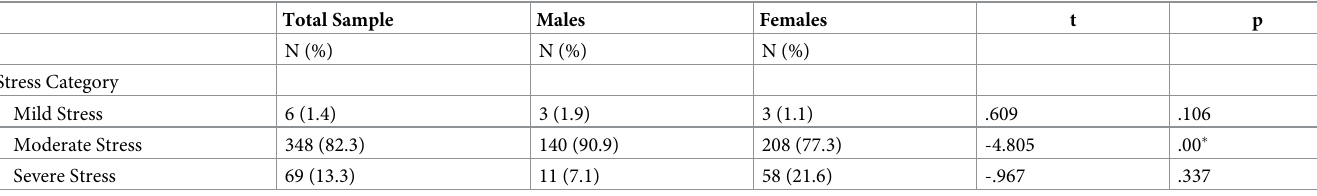
Table 2. Distribution of stress levels in college